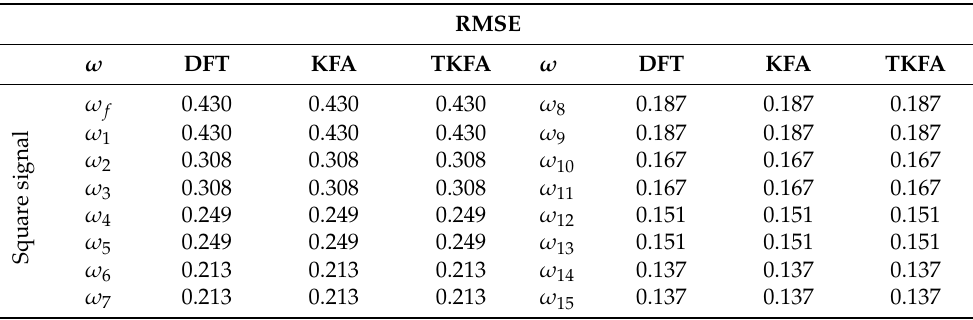
Table 1. RMS Error ( RMSE ) obtained with DFT, KFA and TKFA with respect to the input signal and the approximation to the measurement signal ˆ ζ ( 0 )